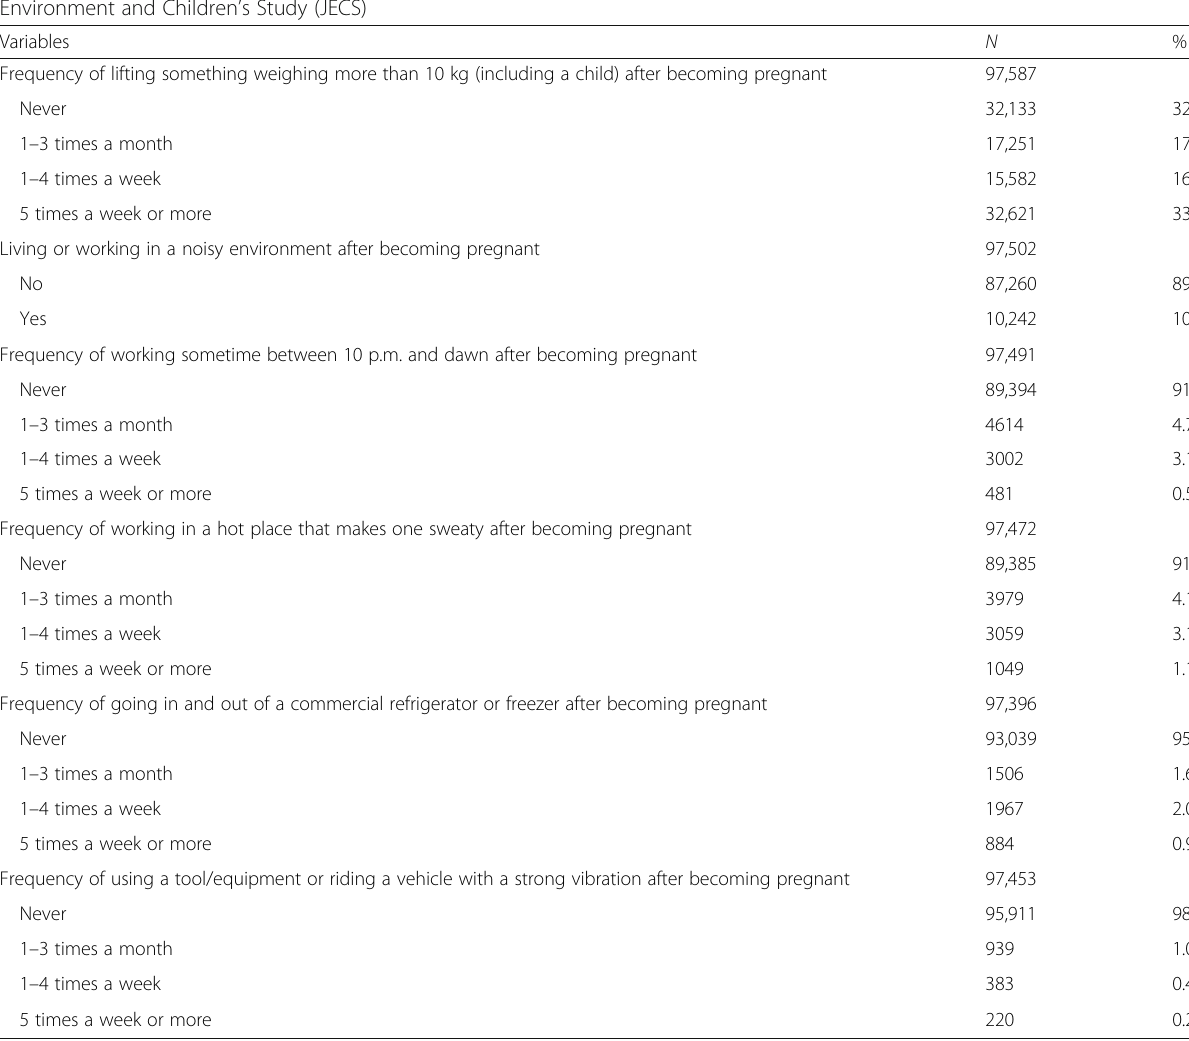
Table 2 Workload characteristics after becoming pregnant as reported via second/third trimester (MT2) questionnaire in the Japan Environment and Children ’ s Study